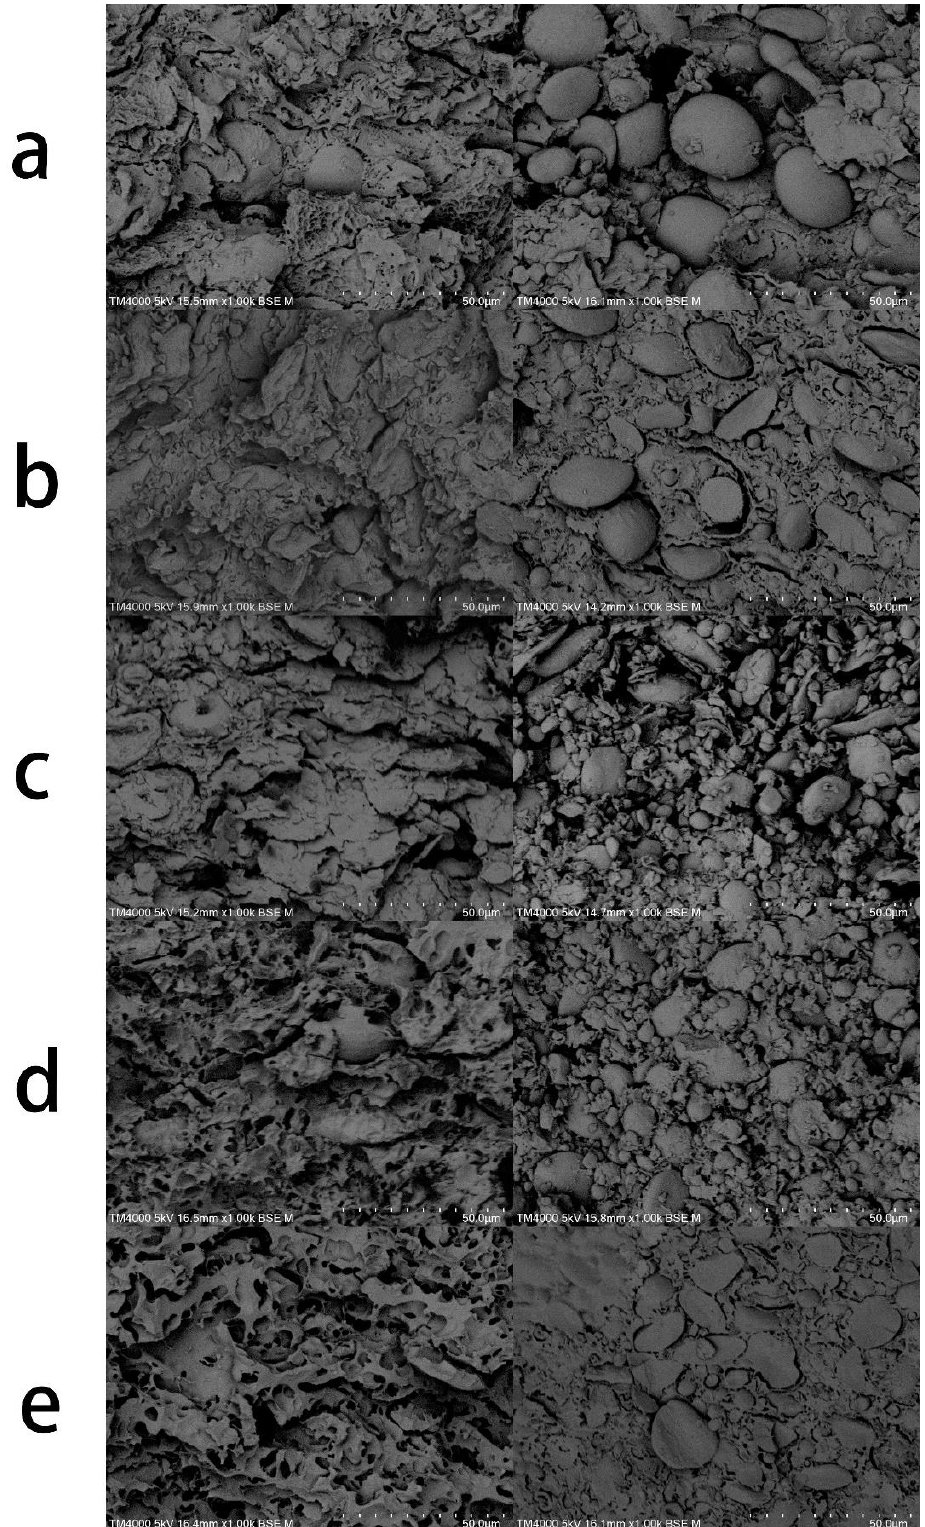
Figure 3. Effects of white kidney bean addition on the microstructure of dough by SEM (1000×). ( a – e ) White kidney bean additions of 0%, 10%, 20%, 30%, and 40%, respectively. The ( left ) side represents cooked noodles, and the ( right ) side represents raw noodles.